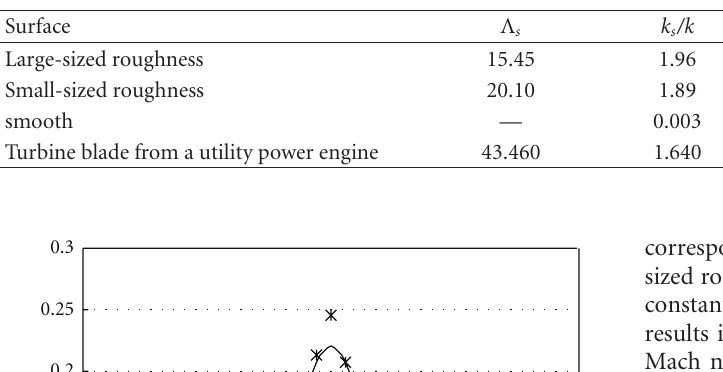
Table 1: Characteristics of rough surfaces employed for the symmetric airfoil investigations [8].